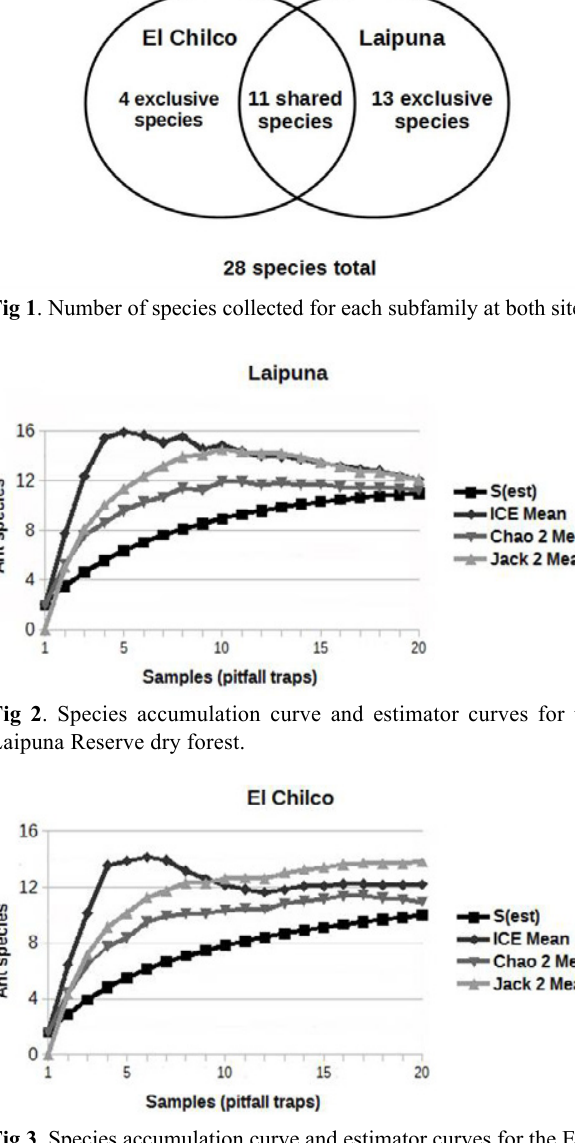
Fig 3 . Species accumulation curve and estimator curves for the El Chilco dry forest.